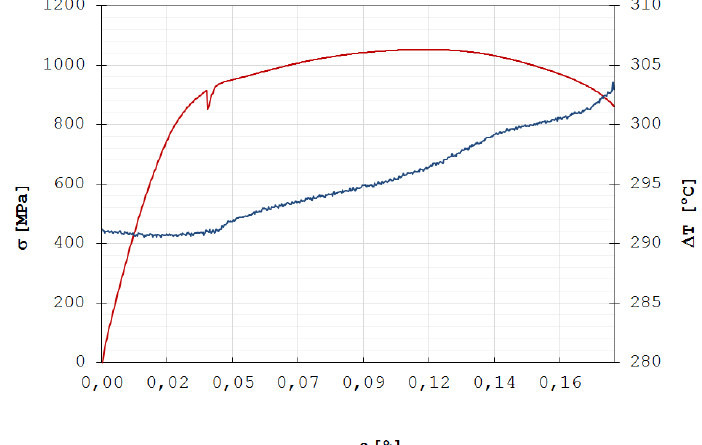
Figure 12: Stress vs strain curve and temperature trend of specimen 2 mono axial static test.